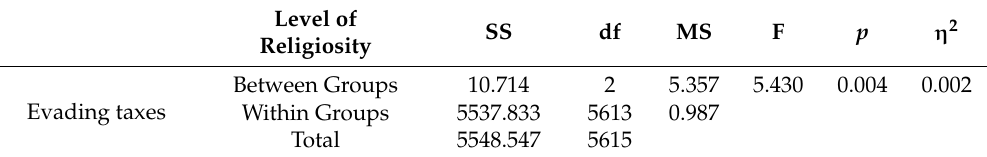
Table A11. Evading taxes among different levels of